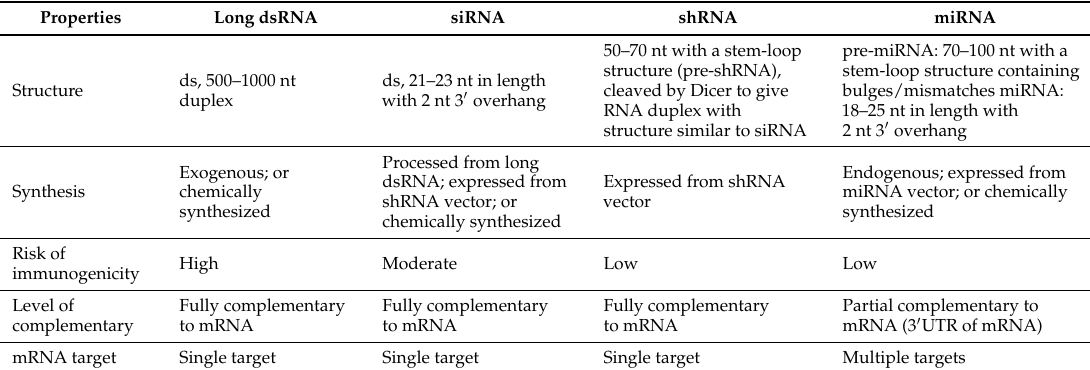
Table 1. Comparison of general properties between long double-stranded RNA (dsRNA), short interfering RNA (siRNA), short hairpin RNA (shRNA) and microRNA (miRNA).